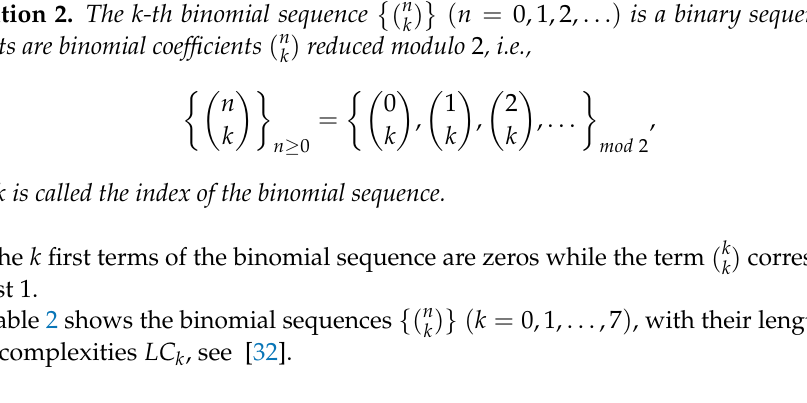
Table 2. Binomial sequences with their lengths l k and linear complexities LC k . Binom. Coeff. Binomial Sequences { ( n